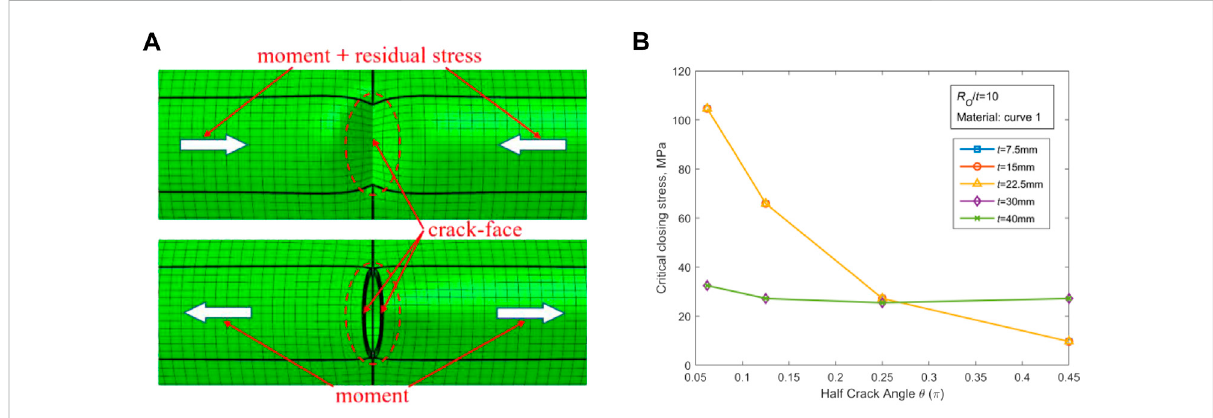
FIGURE 2 ThecrackclosureinducedbythemomentanditscombinationwiththeWRS. (A) Schematicrepresentationofthecrackclosure. (B) PlotsofCCS in terms of crack angle for various crack angles.